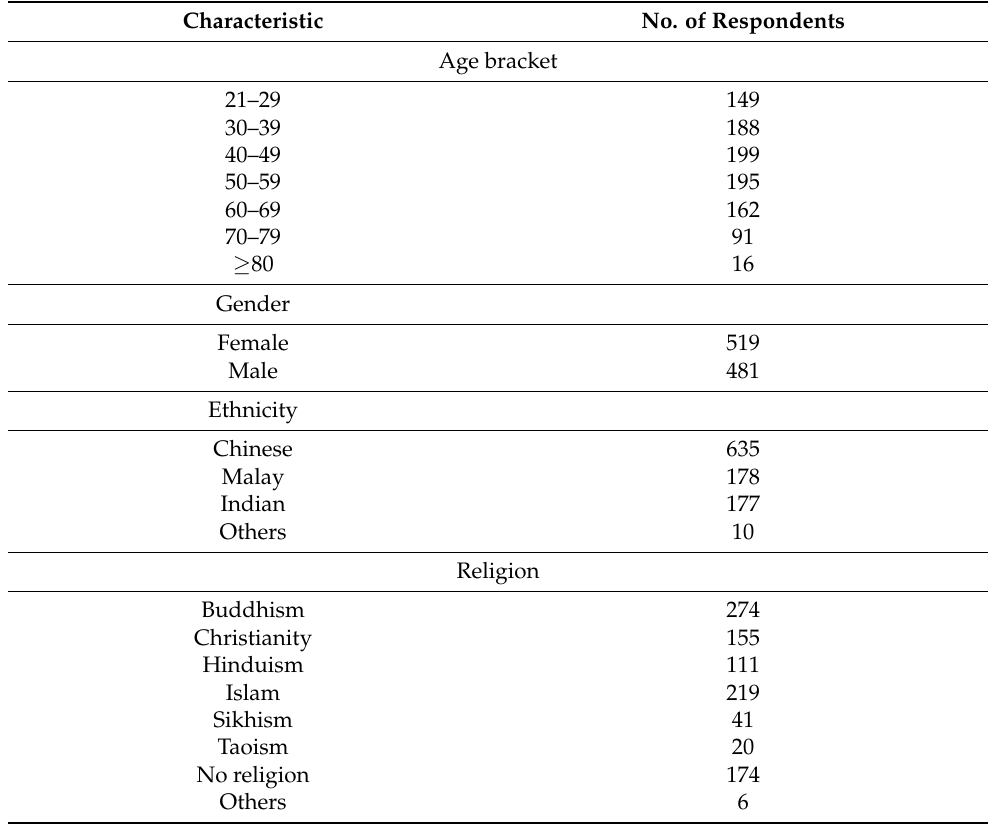
Table 1. Respondent characteristics (sample size n =